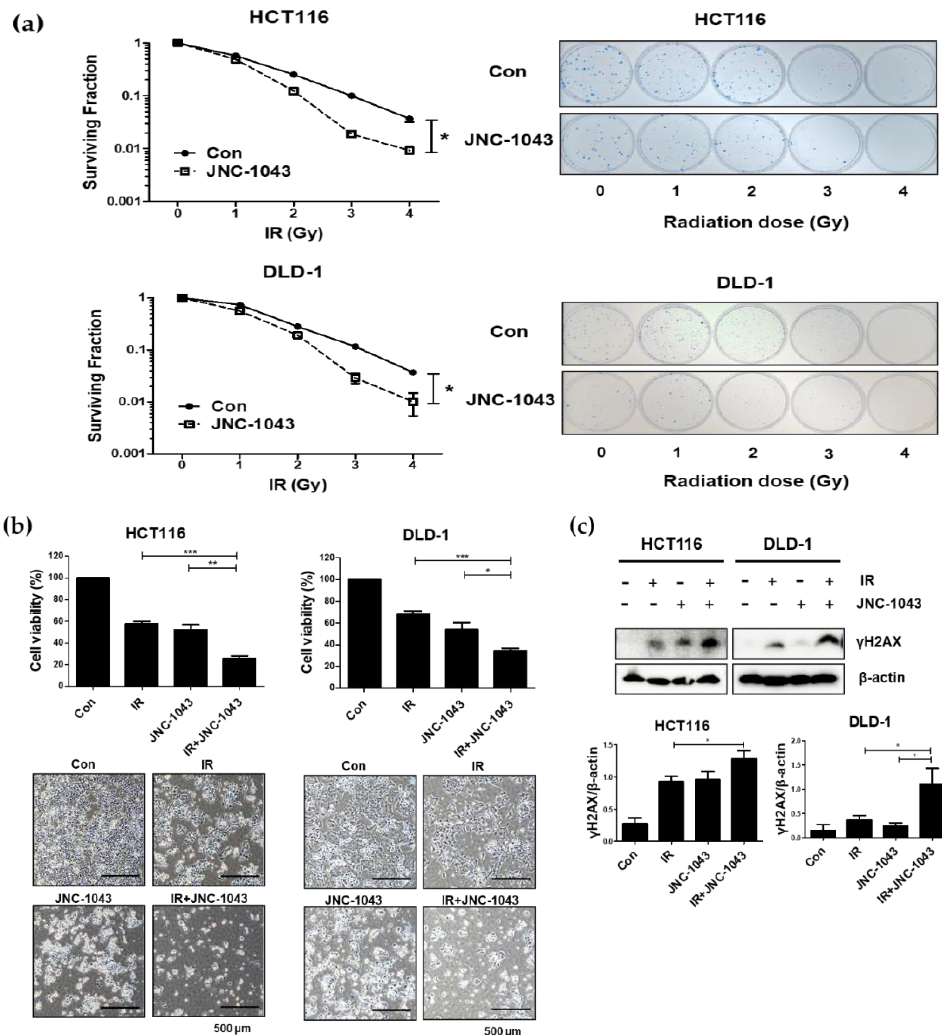
Figure 3. Co-treatment with JNC-1043 and IR suppresses cell growth. ( a ) Clonogenic assay to de-